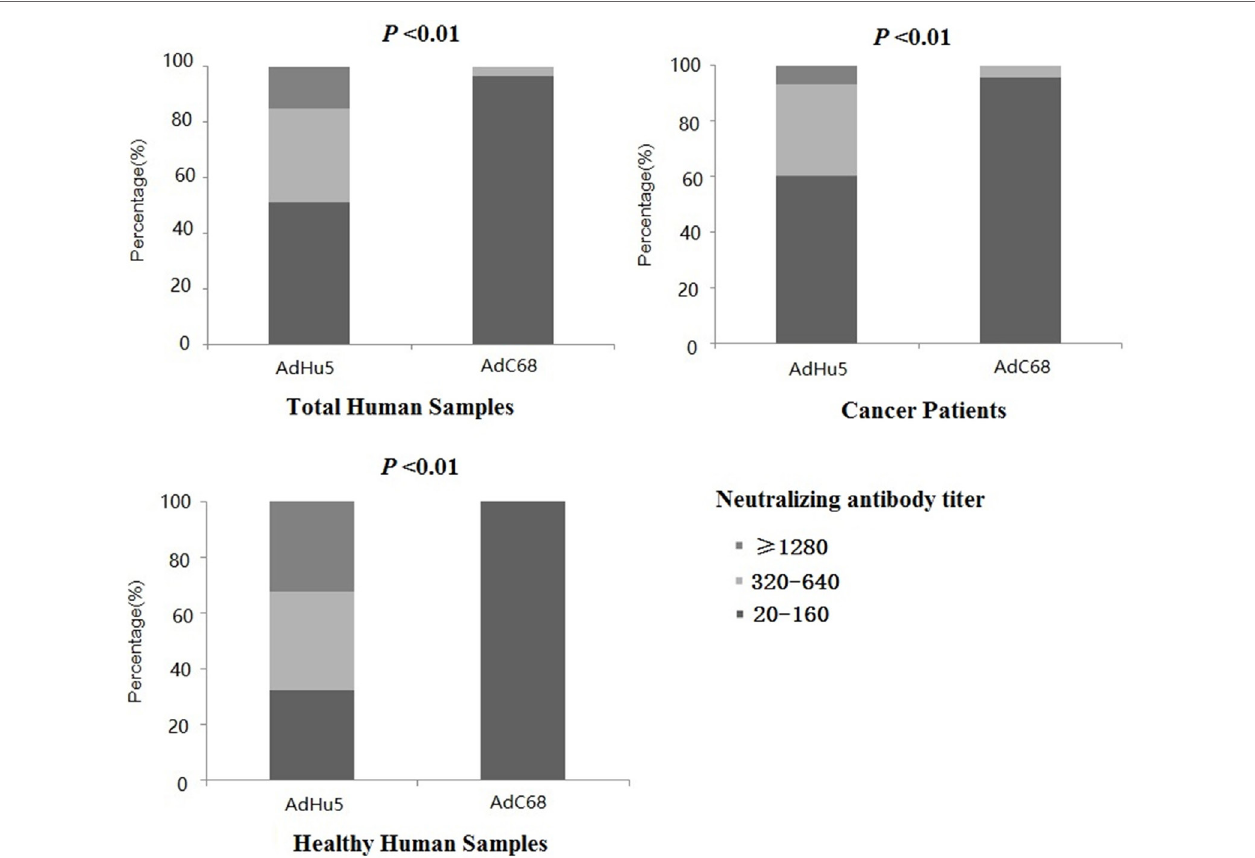
FigUre 1 | Distribution of neutralizing antibody (NAb) titers against AdHu5 and AdC68 in positive samples. NAb titers were stratified in the following tiers: low titer ( ≥ 20 and ≤ 160), medium titer ( ≥ 320 and ≤ 640), and high titer ( ≥ 1,280). Across positive samples from all of the human subjects, the NAb titers against AdHu5 from low to high were 51.02, 33.79, and 15.19%, respectively. The AdC68 NAb titers in positive samples from low to high were 96.67, 3.33, and 0%, respectively, which was significantly different from AdHu5 ( P < 0.01). For positive samples from the cancer subjects, the NAb titers against AdHu5 from low to high were 51.02, 33.79, and 15.19%, respectively. However, most cancer subjects exhibited low NAb titers against AdC68 ( ≥ 20 and ≤ 160, 95.83%), and a small fraction of cancer subjects exhibited a medium level of AdC68 NAb titers ( ≥ 320 and ≤ 640, 4.17%). For the healthy adult volunteers, the AdHu5 NAb titers in the positive samples from low to high were 32.19, 35.62, and 32.19%, respectively, whereas all of titers from the positive NAb samples against AdC68 were lower or equal to